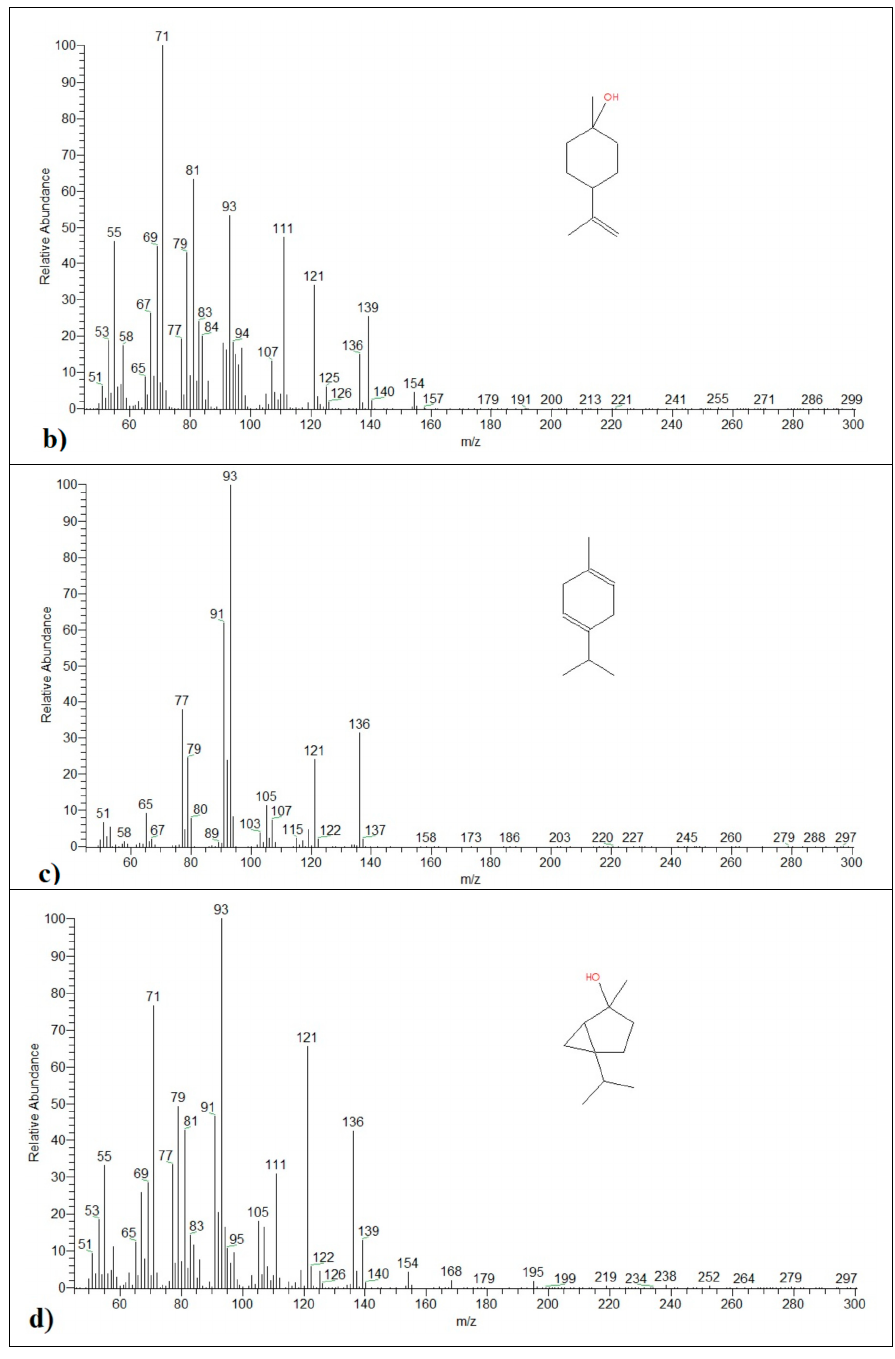
Figure 5. The 70 eV mass spectrum of 4-Terpineol ( a ), cis- β -Terpineol ( b ), γ -Terpinen ( c ), and (1 α ,2 β ,5 α )-Bicyclo[3.1.0]hexan-2-ol,2-methyl-5-(1-methylethyl) ( d ) components of Corymbia citriodora fruits’ recovery